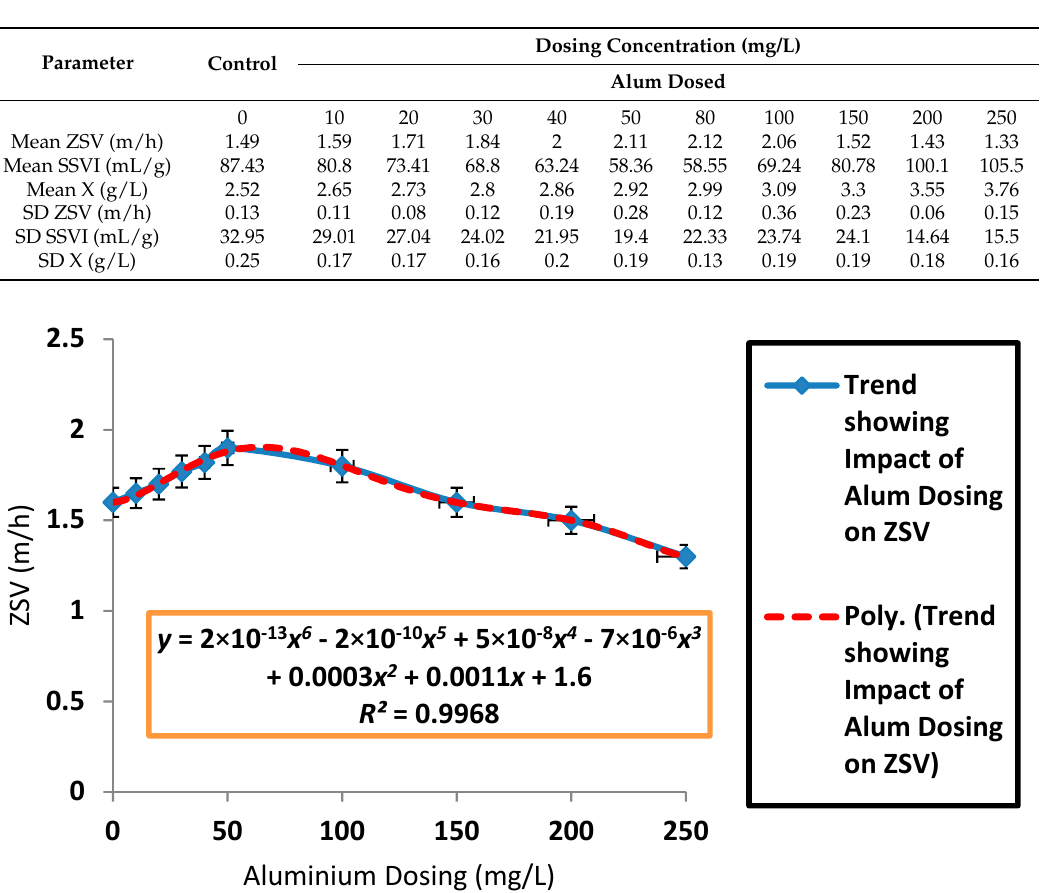
Table 1. Mean and standard deviation data of zone settling velocity (ZSV) and stirred specific volume